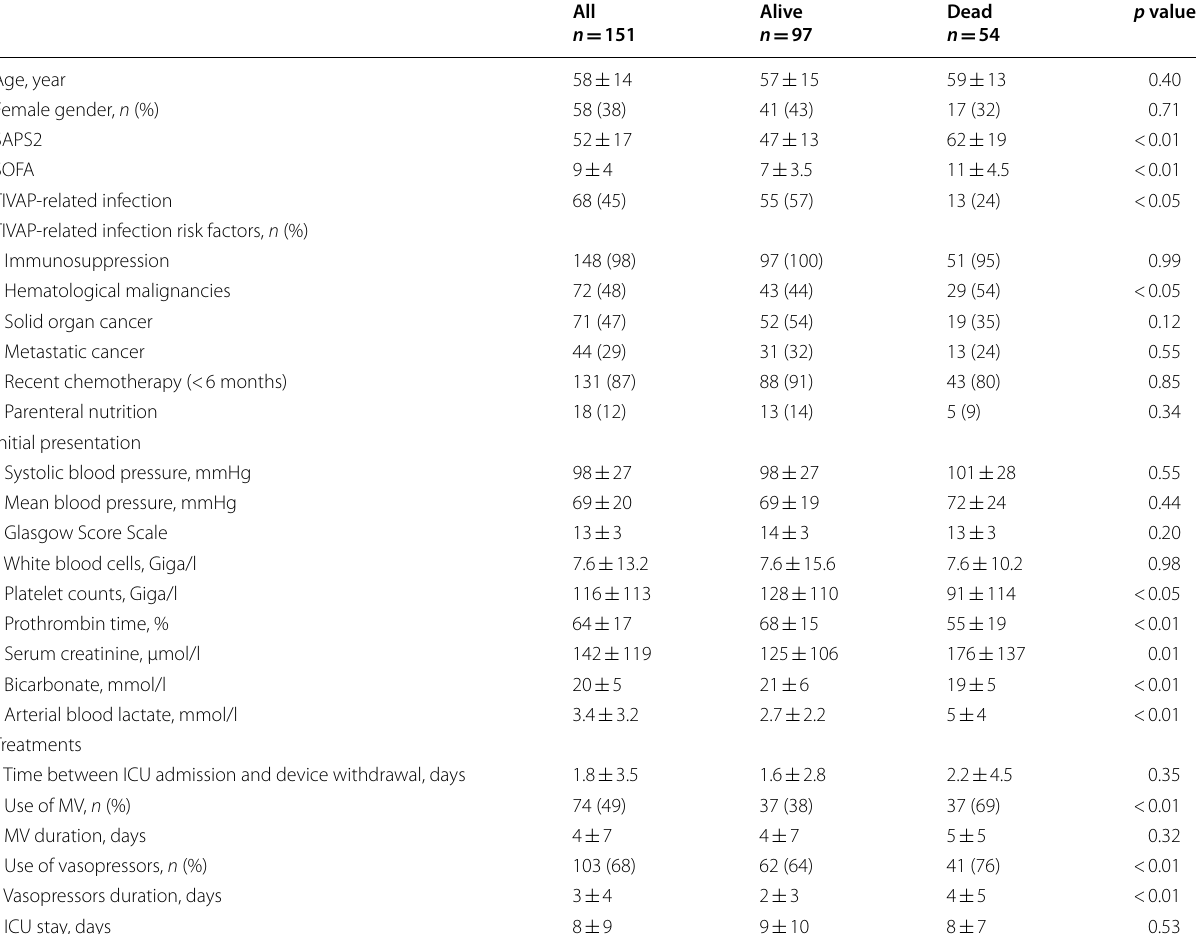
Table 5 Variables associated with 28-day